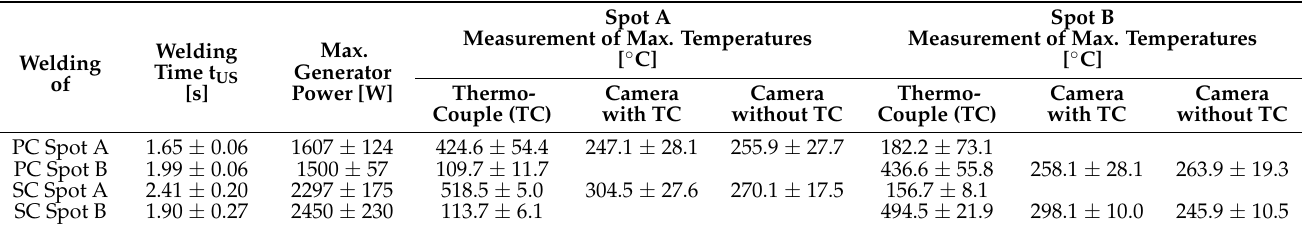
Table 4. Results from the thermal analysis in relation to welding times and peak generator powers during ultrasonic spot welding of AA6005A to HCT980X.